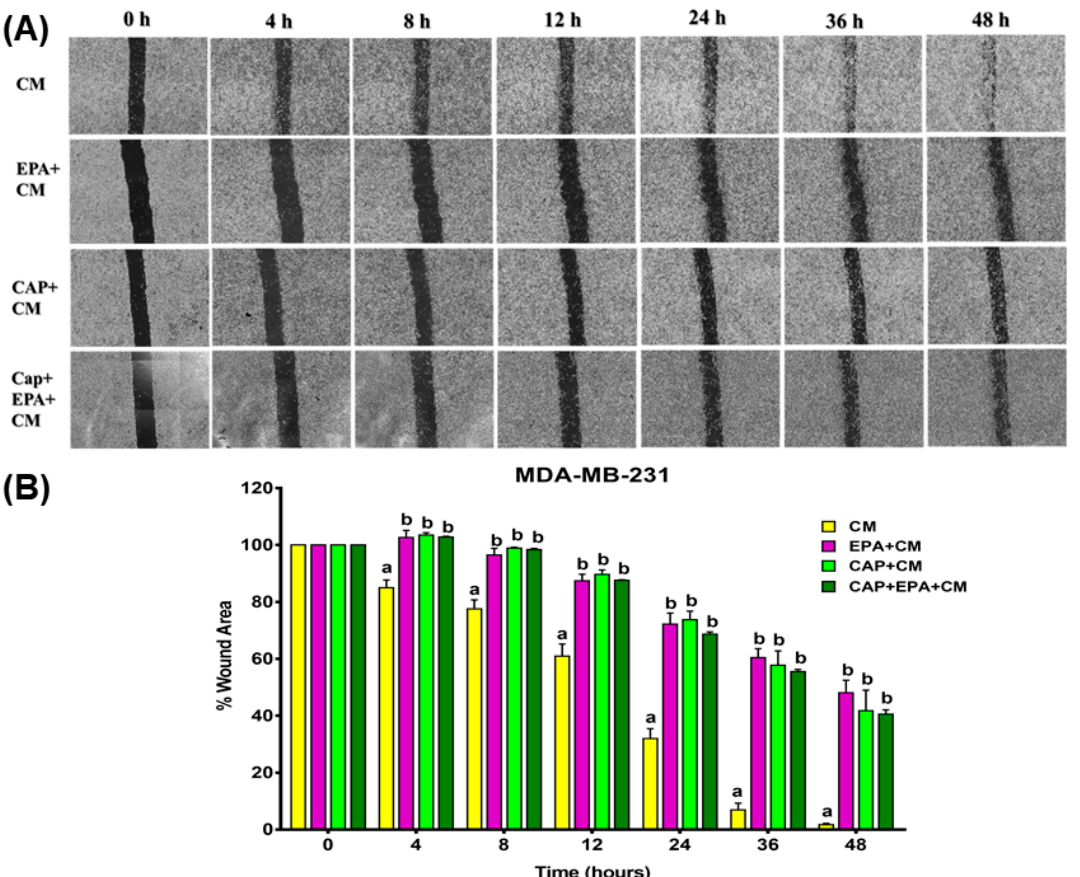
Figure 5. CM-mediated effect of captopril and EPA on cell migration in MDA-MB-231 cells. Representative wound healing images at 0, 4, 8, 12, 24, 36, and 48 h. Wounds were inflicted with a 200 uL pipette tip on MDA-MB-231 ( A , B ) cells in confluent monolayers. Graphical representation of migrating MDA-MB-231 ( A , B ) cells in response to CM-EPA and CM-CAP with or without EPA treatments of BC cells. Cells treated with human adipose conditioned medium were used as controls (CM). Bars represent mean of the percent wound area in MDA-MB-231 ( A , B ) cells in the two independent experiments ± SEM. p < 0.05 (comparison between 0 and 48 h; N = combined experiments, in which each had three replicates per treatment group). Different letters (a, b) indicate significance.